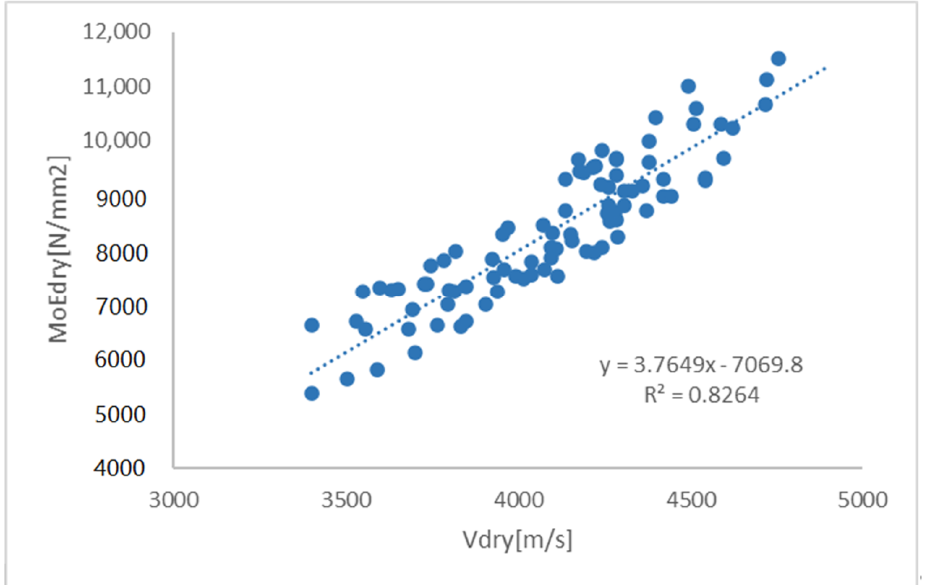
Figure 10. MoE dyn vs. wave velocity V—Dry condition.